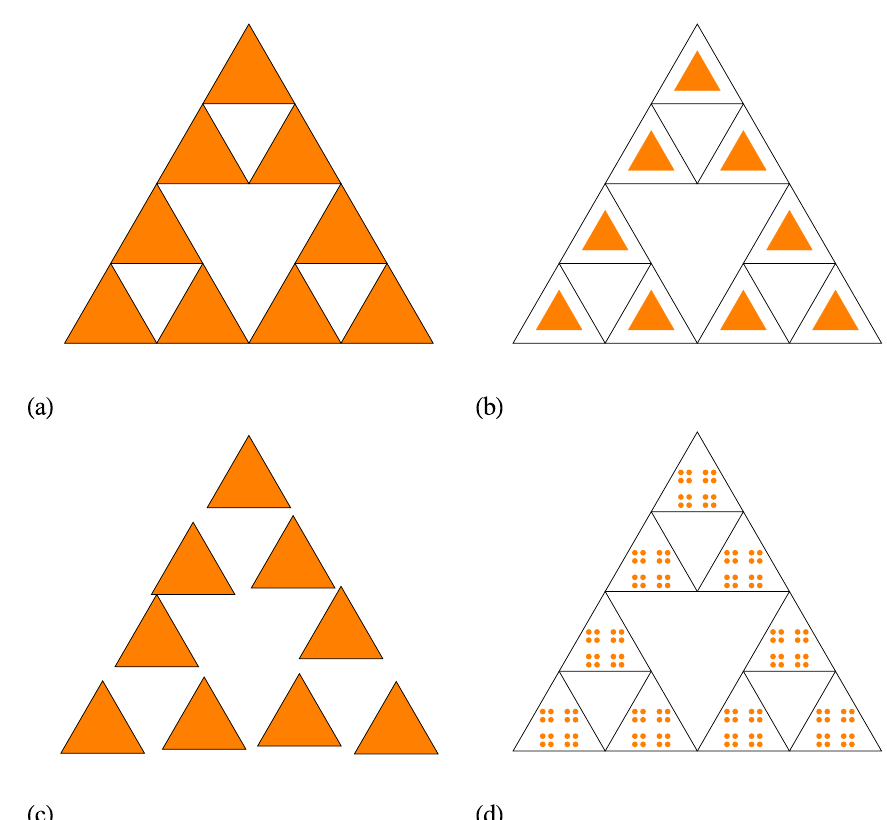
Figure 2. Various models of Sierpi´nski triangle (ST) fractals at iteration m = 2. ( a ) Regular ST (model ST). ( b ) Scaled ST (model SST). ( c ) Randomised ST (model RST). ( d ) Complex ST (model